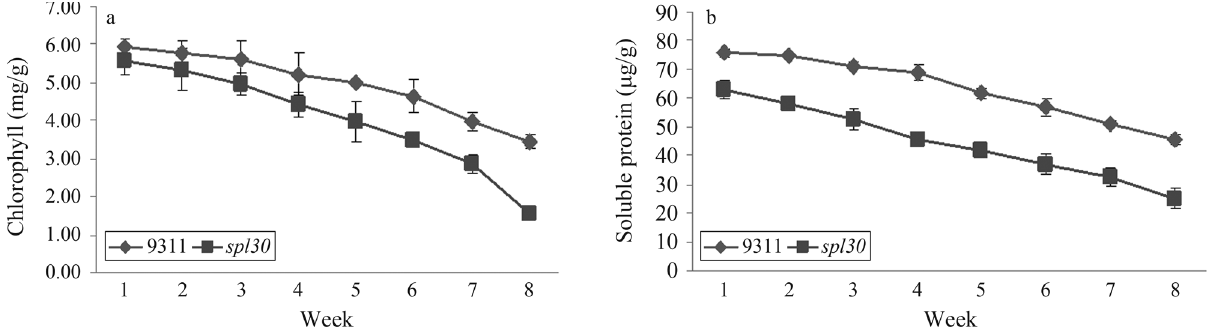
Figure 3 - Analysis of chlorophyll content (a) and soluble protein (b) content, two indicators of